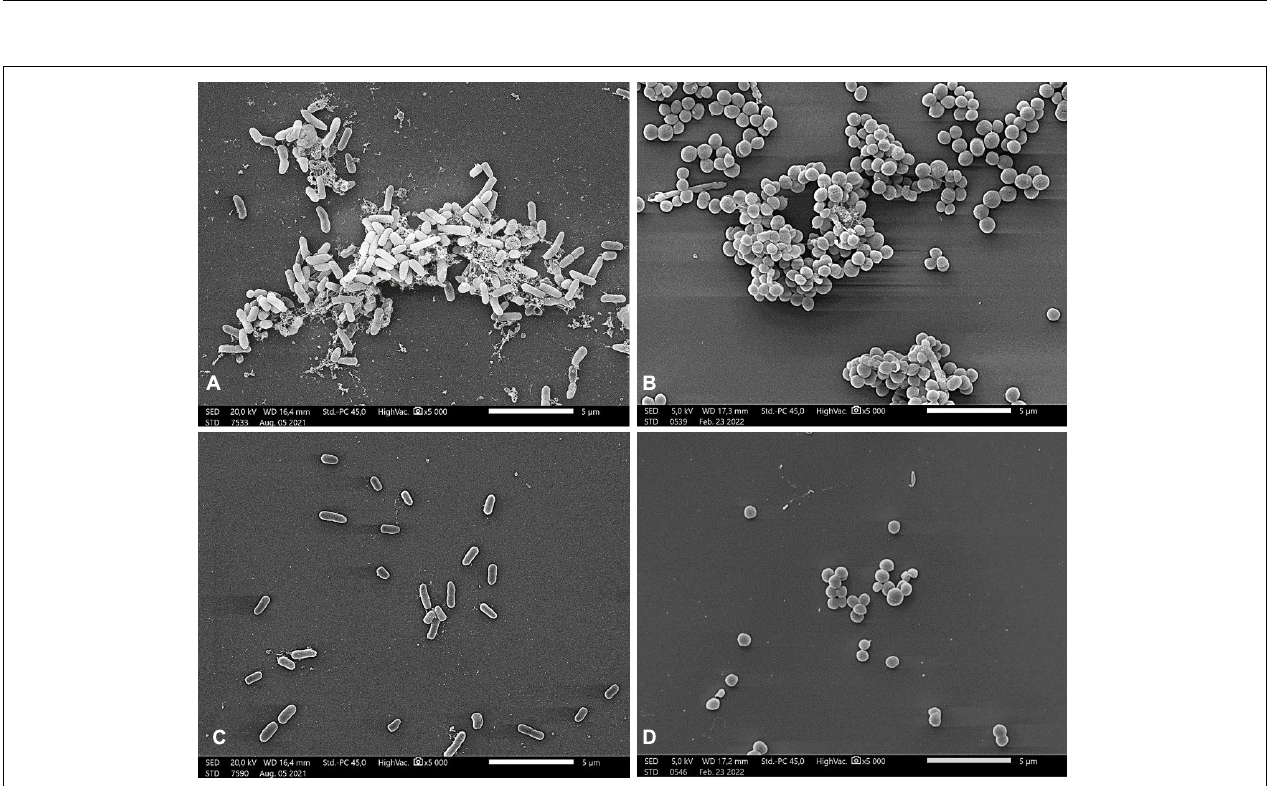
FIGURE 2 | Scanning electron microscopic images of P. aeruginosa (A,C) and S. aureus (B,D) Control samples of bacterial strains (A,B) ; treatment with 25.25% (w/v) and 22.75% (w/v) linden honey in case of P. aeruginosa and S. aureus , respectively (C,D) . Scale bar = 5 µ m.